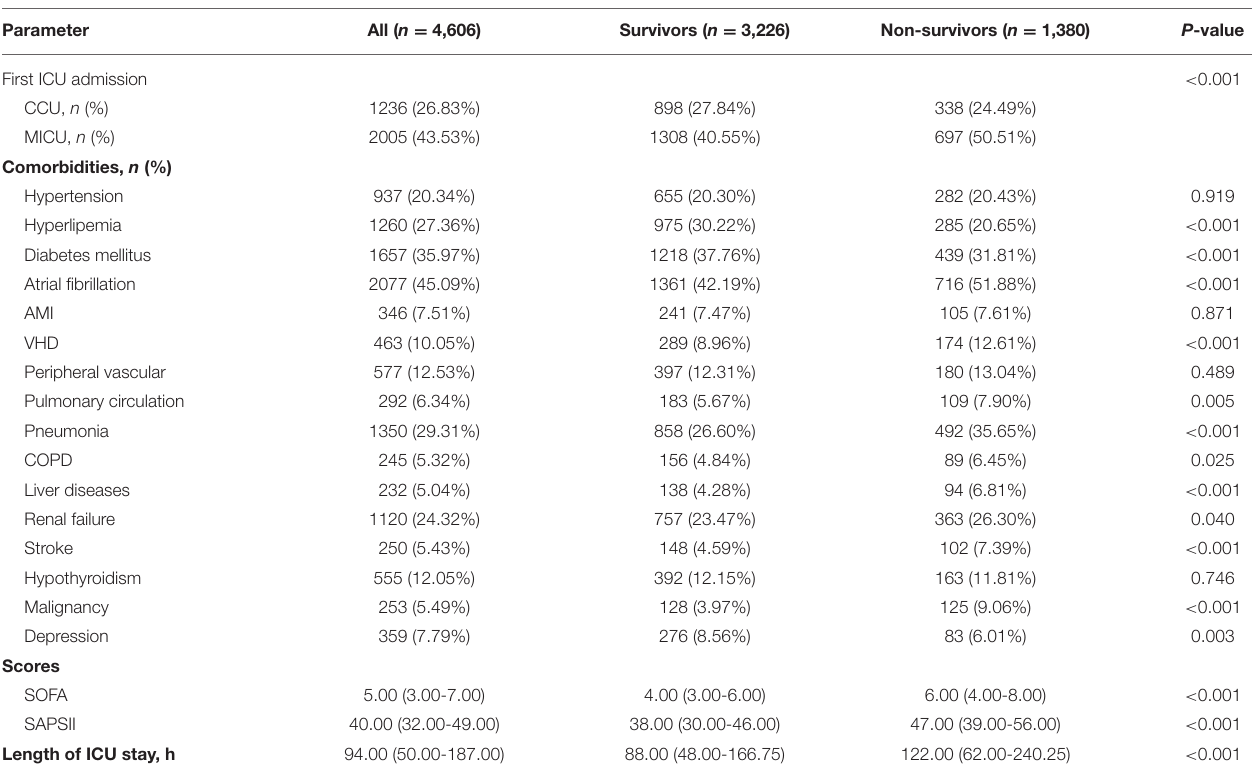
Frontiers in Cardiovascular Medicine |